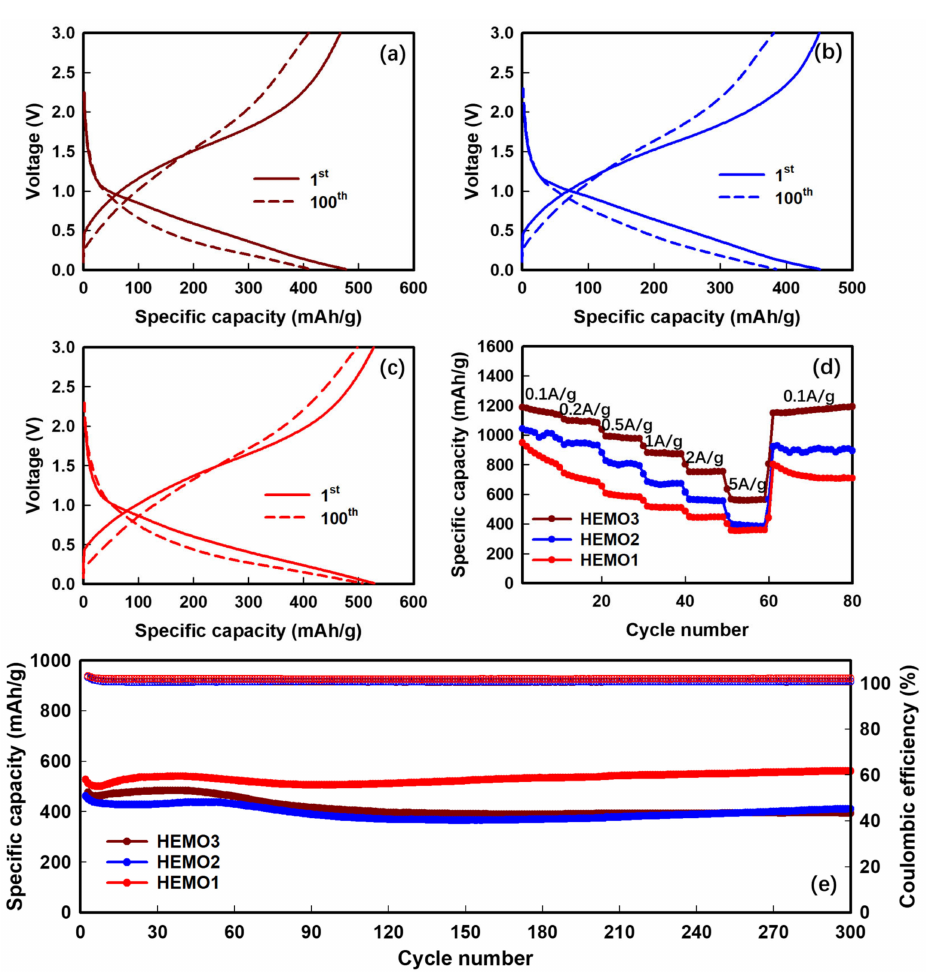
Figure 7. Electrochemical performances of different HEMO anodes used in LIBs. Charge/discharge profiles for the fabricated ( a ) HEMO1, ( b ) HEMO2, and ( c ) HEMO3 anodes at 5 A g − 1 , ( d ) rate capabilities, and ( e ) cycle performance under 5 A g − 1